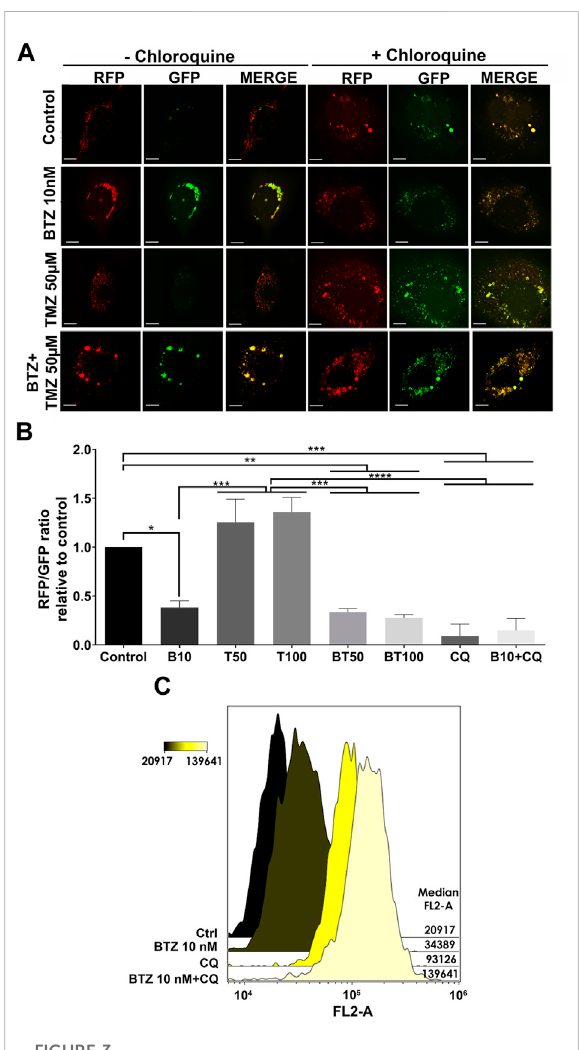
FIGURE 3 LC3A/B+ autophagosomes accumulate in response to BTZ and combination BTZ + TMZ treatment of GBM cells (A) Confocal microscopy of P3 cells transfected with RFP-GFP-LC3B